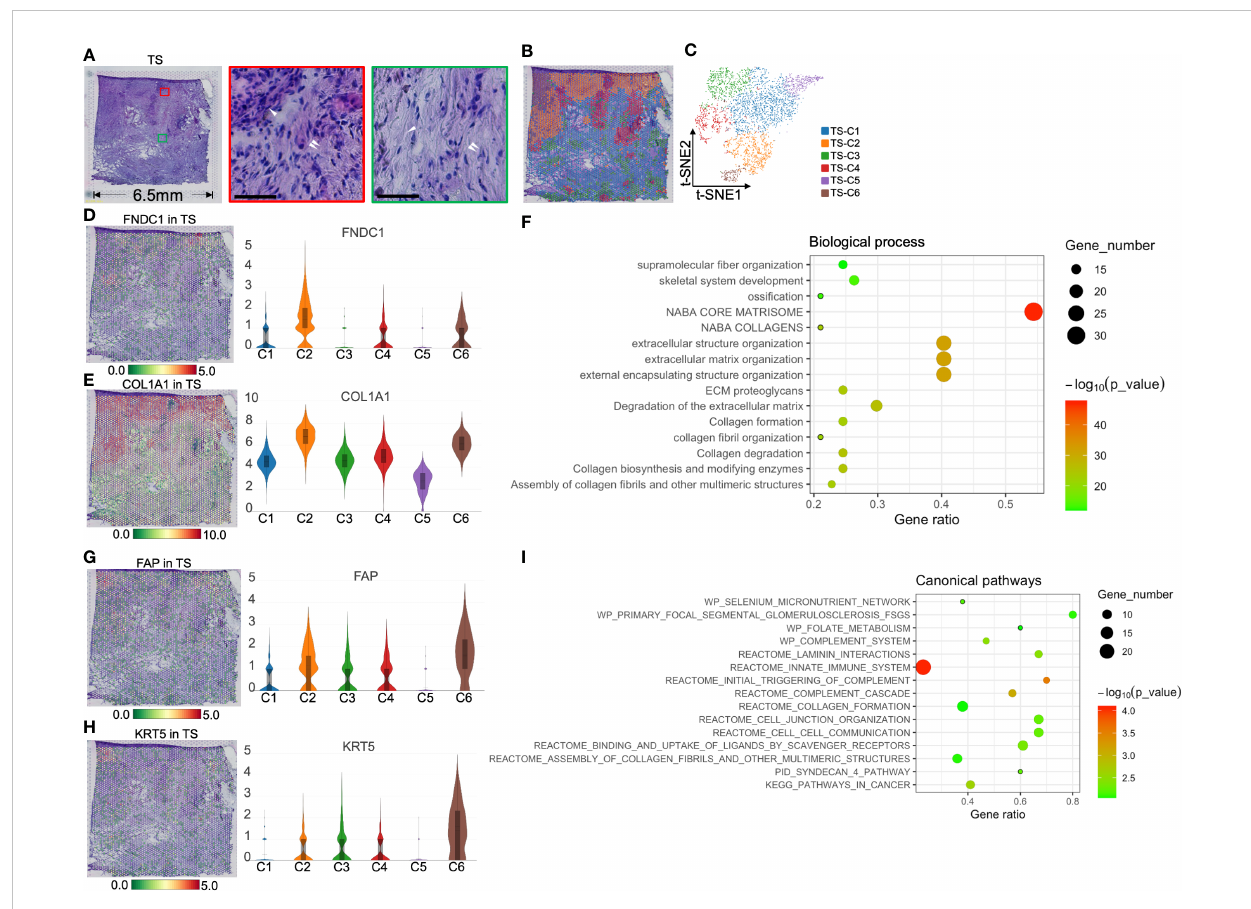
FIGURE 6 Clustering and spatial distribution of the spots from tumor stroma (TS). (A) Hematoxylin and eosin stained images of the tumor stroma. The red box and the middle image show islet cells (white single arrow) and the surrounding extracellular matrix and CAFs (white double arrow). The green box marks the necrotic area (white single arrow), showing the rich extracellular matrix and a few stromal cells (white double arrow). Scale bars = 50 m m. Spatial distribution (B) and t-SNE plot (C) of six clusters in tumor stroma. The level and distribution of FNDC1 (D) and COL1A1 (E) in tumor stroma. (F) Biological process analysis for TS-Cluster (C)2. The level and distribution of FAP (G) and KRT5 (H) in tumor stroma. (I) The canonical pathway enrichment analysis for TS-C6. The bar plots and the vertical coordinate of the violin plots indicates the log 2 FC of the gene expression value of each cluster versus the average gene